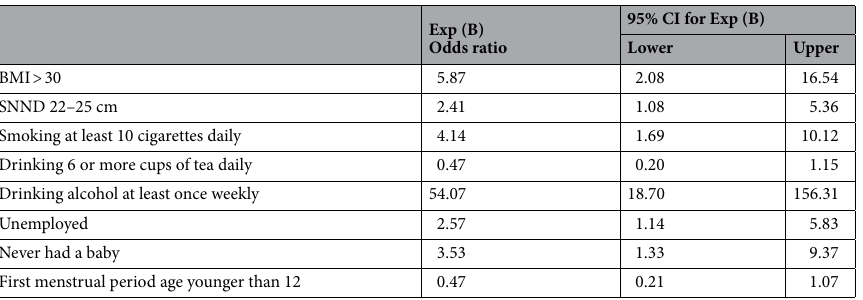
Table 7. Logistic regression model of risk factors (severe mastalgia)—backward method results. Pseudo (Nagelkerke) R 2 = 0.541, Hosmer–Lemeshow χ 2 = 38.397, p < 0.001. (Step 6). CI confidence interval, OR odds ratio, BMI body mass index, SNND distance from the sternal notch to the nipple, Severe mastalgia VAS score ≥